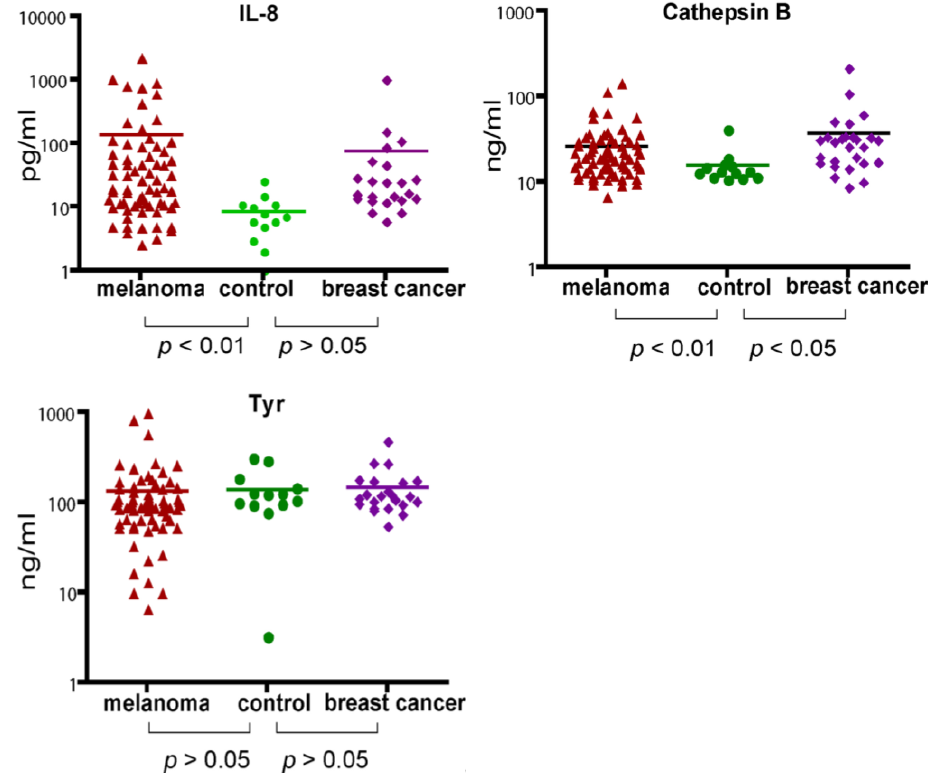
Figure 2. Comparison of serum cathepsin B, IL-8 and Tyrosinase in melanoma, breast cancer and healthy controls.